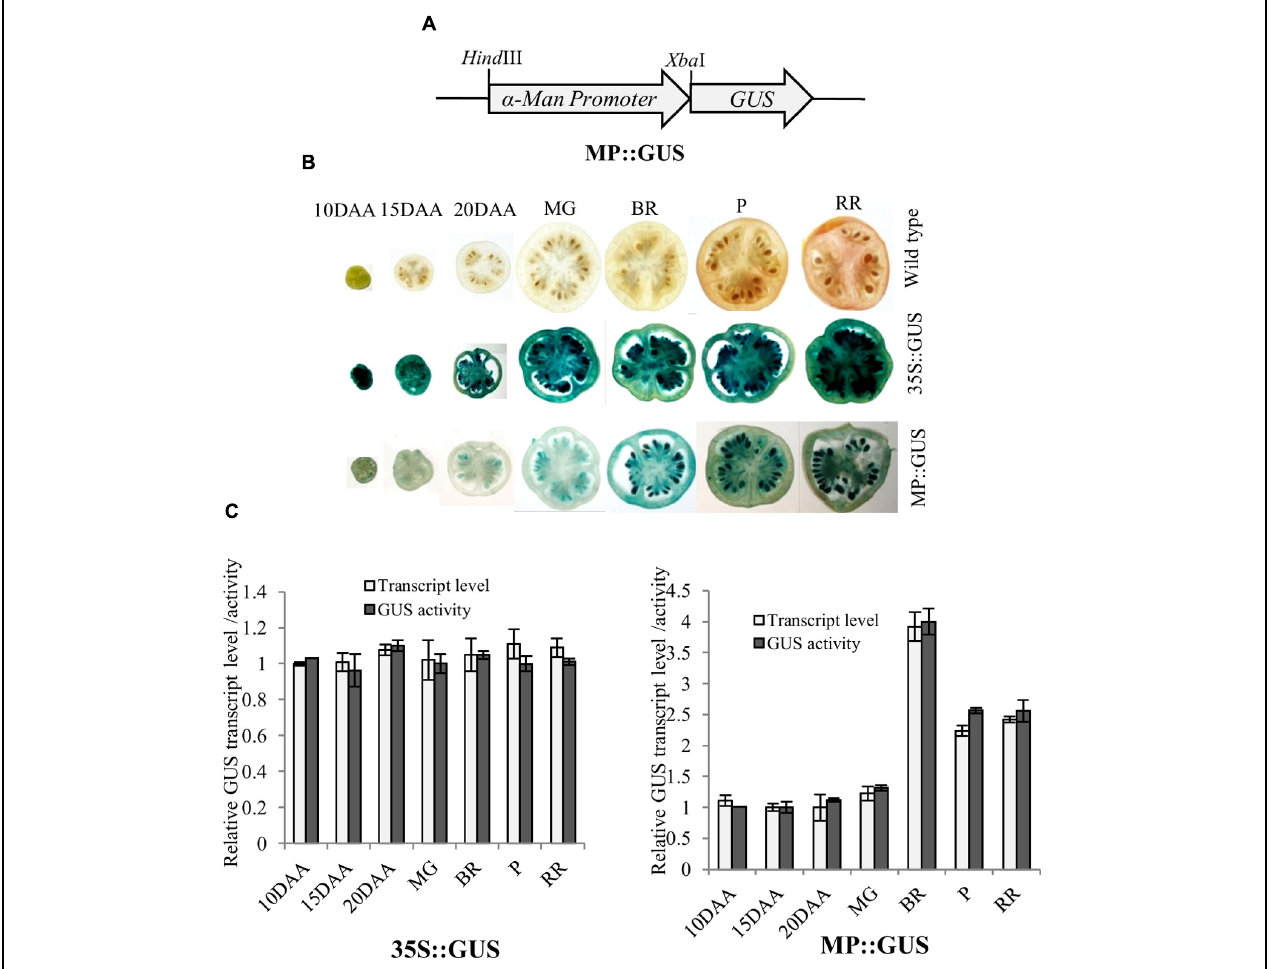
FIGURE 2 | Histochemical and fluorometric assays of GUS activity in fruits. (A) Schematic representation of MP::GUS fusion construct ( GUS fused with α -Man promoter). (B) Histochemical GUS staining was carried out in fruits of different developmental and ripening stages. MP::GUS and 35S::GUS denote MP and CaMV35S promoter driven expression of GU S. Wild type was used as untranformed control. (C) Accumulation of GUS transcript and activity in transgenic fruits were measured by qRT-PCR and fluorometric GUS assay, respectively. Tomato actin was used as endogenous control in qRT-PCR. Data are mean ( ± SE) of three biological